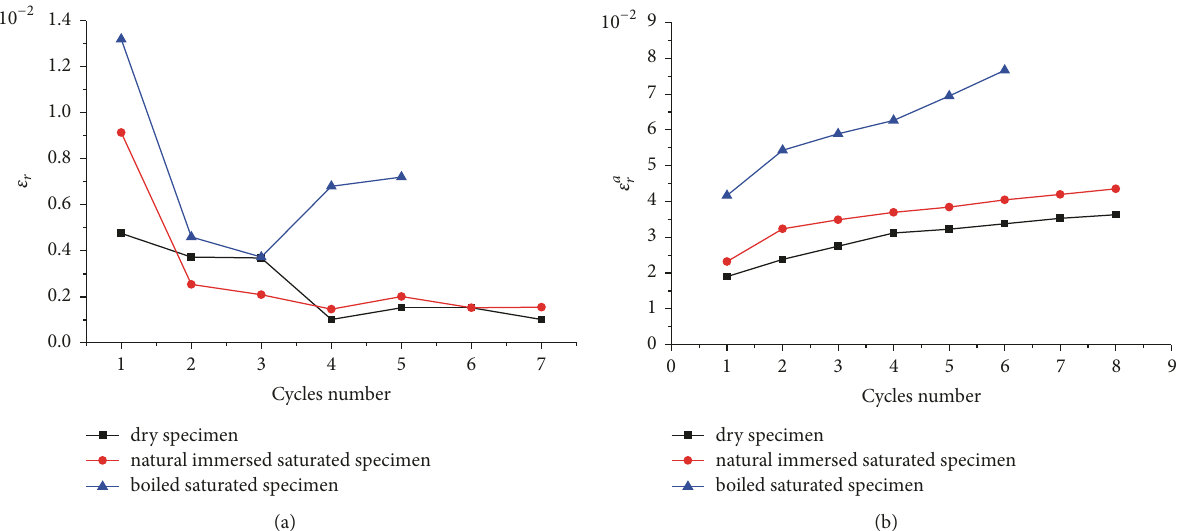
Figure 9: Residual strains of the three specimens in each loading cycle. Residual nominal strain (a) and the accumulated residual strain (b).